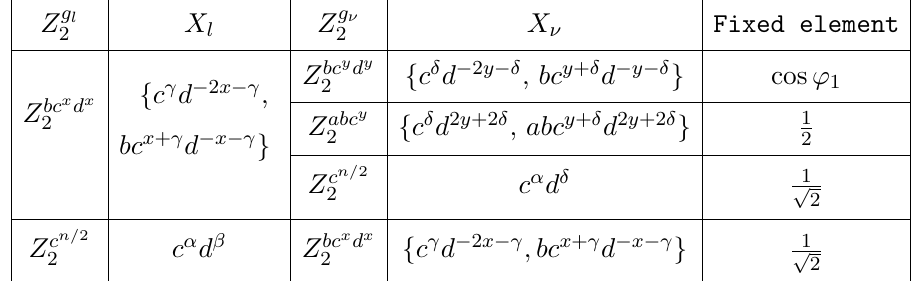
Table 2 . The four viable combinations of residual symmetries with the structure Z 2 (cid:2) CP in the neutrino and charged lepton sectors, where the parameters x , y , (cid:11) , (cid:12) , (cid:13) and (cid:14) can take integer values between 0 and n (cid:0) 1. The angle ’ 1 = ( x (cid:0) y ) (cid:25)=n is determined by the choice of residual